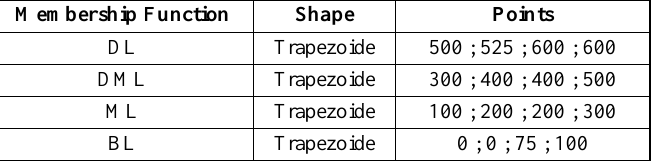
Table 3: Photo member functions l.